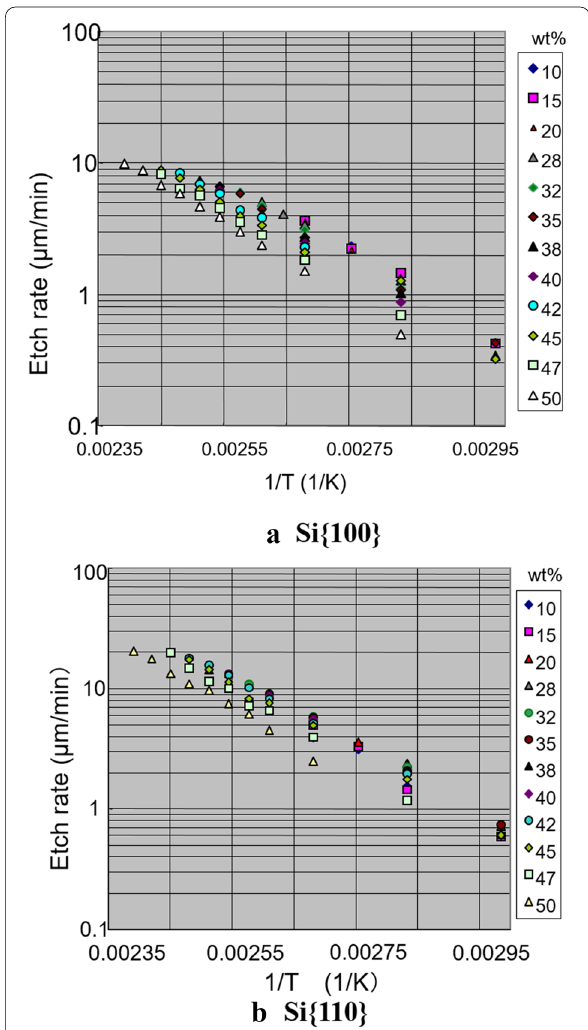
Fig. 17 Arrhenius plots of Si{100} and Si{110} etching rates for different concentrations of KOH aqueous solutions